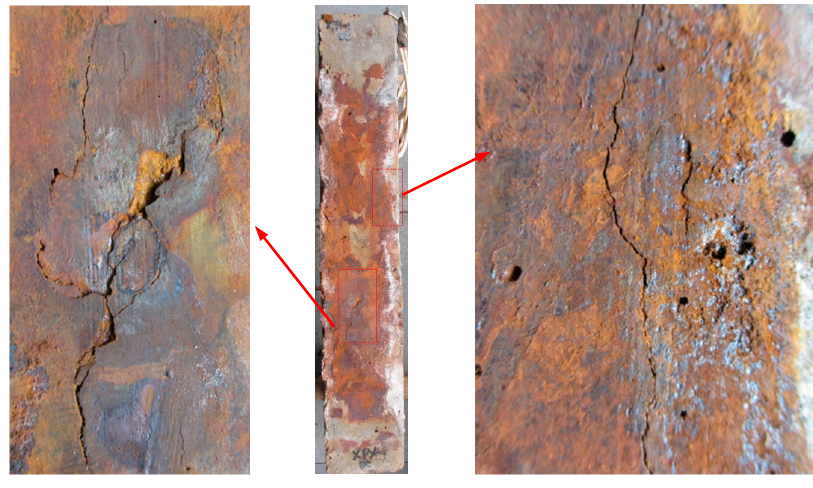
Figure 12. Cracks due to volumetric increase by rust formation on the surfaces of the RC column specimens.